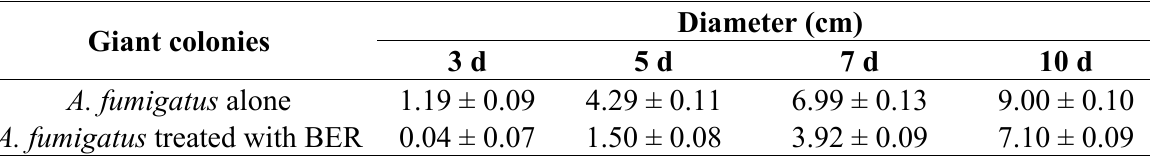
Table 2. The colony sizes of A. fumigatus alone or A. fumigatus treated with BER (at 128 μ g/mL). Giant colonies